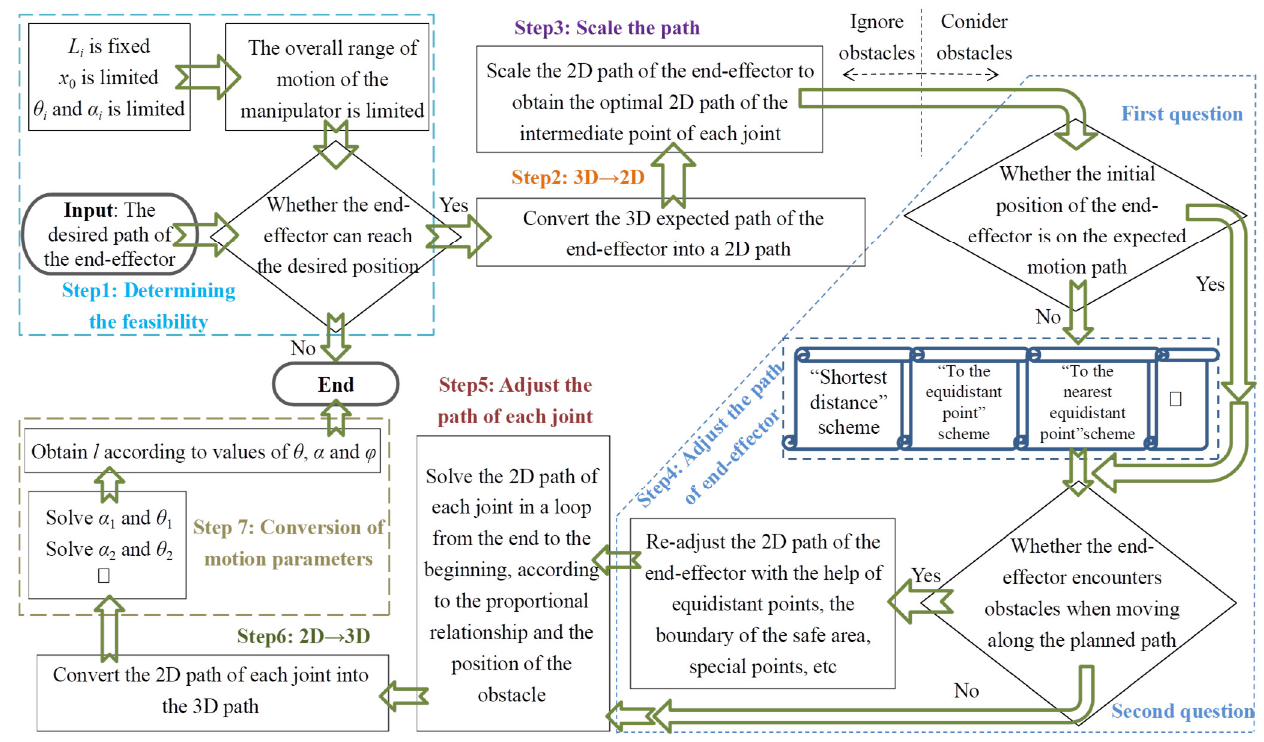
Figure 3. Flow chart of VDSM.